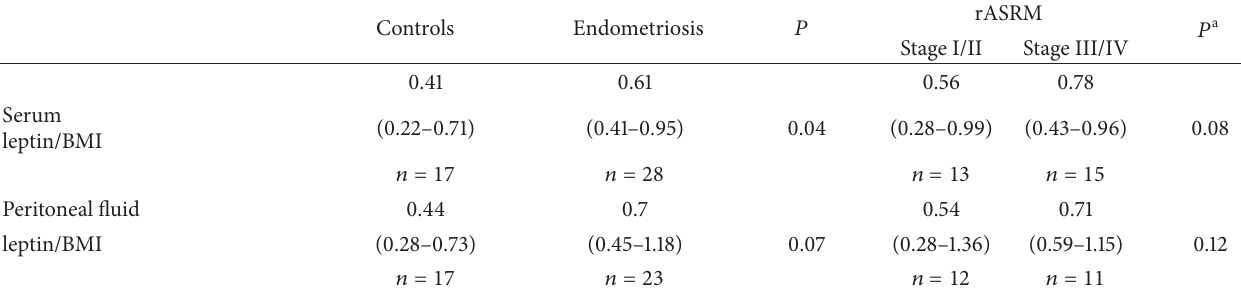
Table 2: Serum and peritoneal fluid leptin/BMI ratio according to stage of